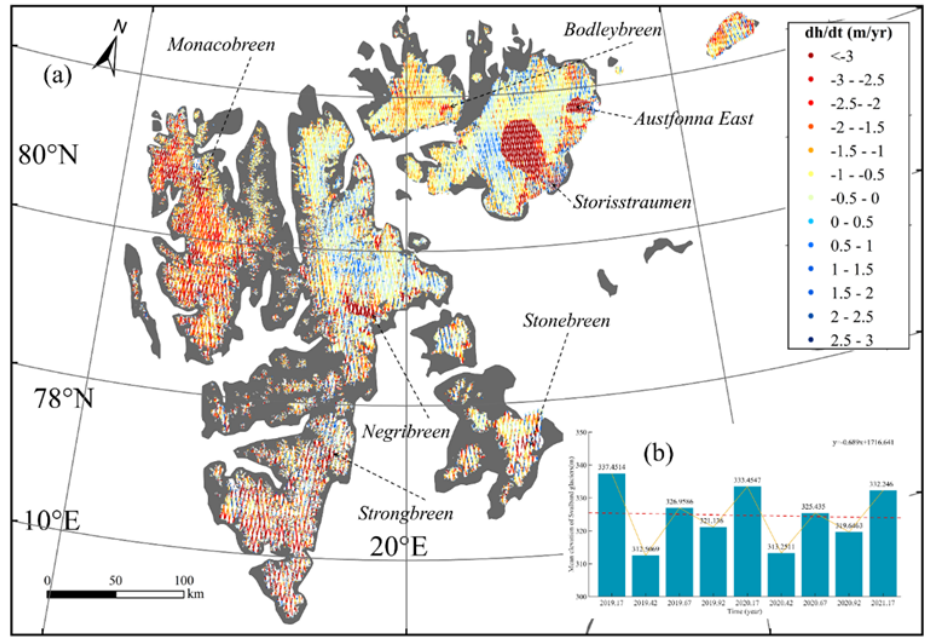
Figure 2. ( a ) Average glacier elevation change rates ( dh / dt ) across the Svalbard archipelago in 2019 – 2021. ( b ) Mean elevation time series of Svalbard glaciers in 2019 – 2021. Blue bar is the mean elevation, red dashed line is the trend line.